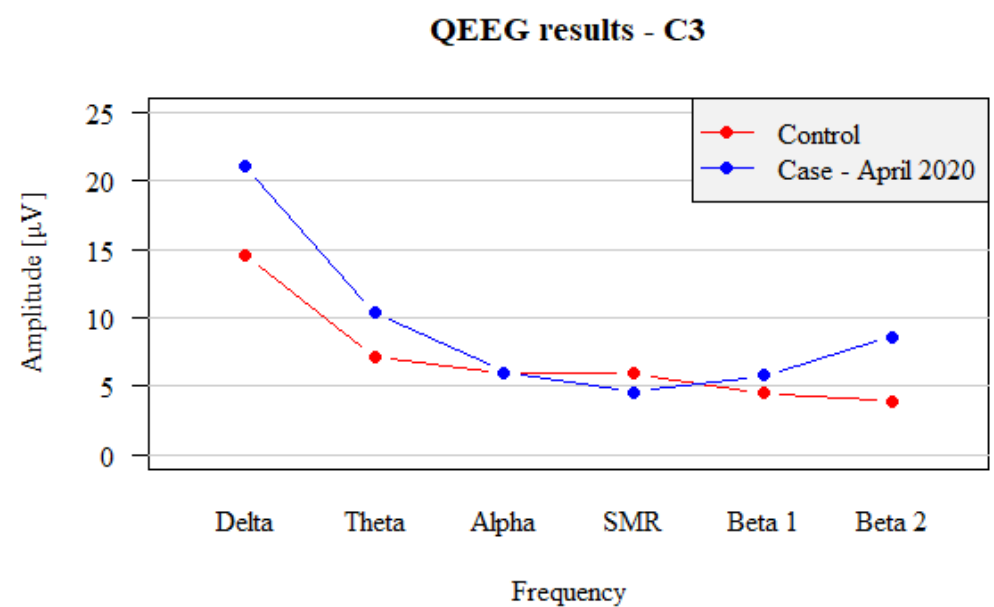
Figure 1. Comparison between left hemispheric (C3) QEEG recordings in test patient with panic attacks (blue dots and lines) before the treatment vs. non-affected subject (control, red dots and lines).